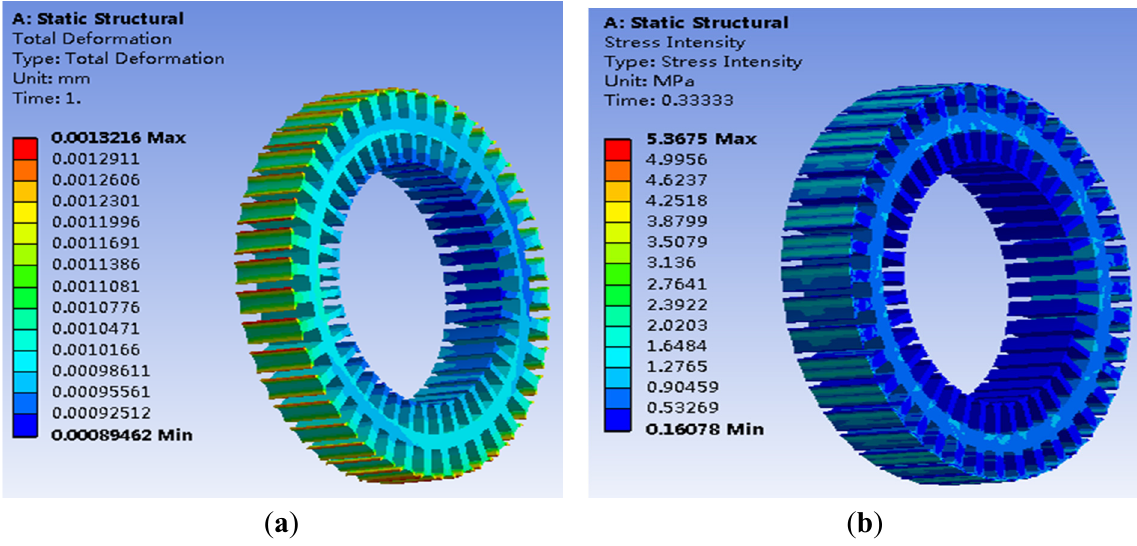
Figure 19. The stator of 1 kW DRPMSM: ( a ) deformation; and ( b ) stress density